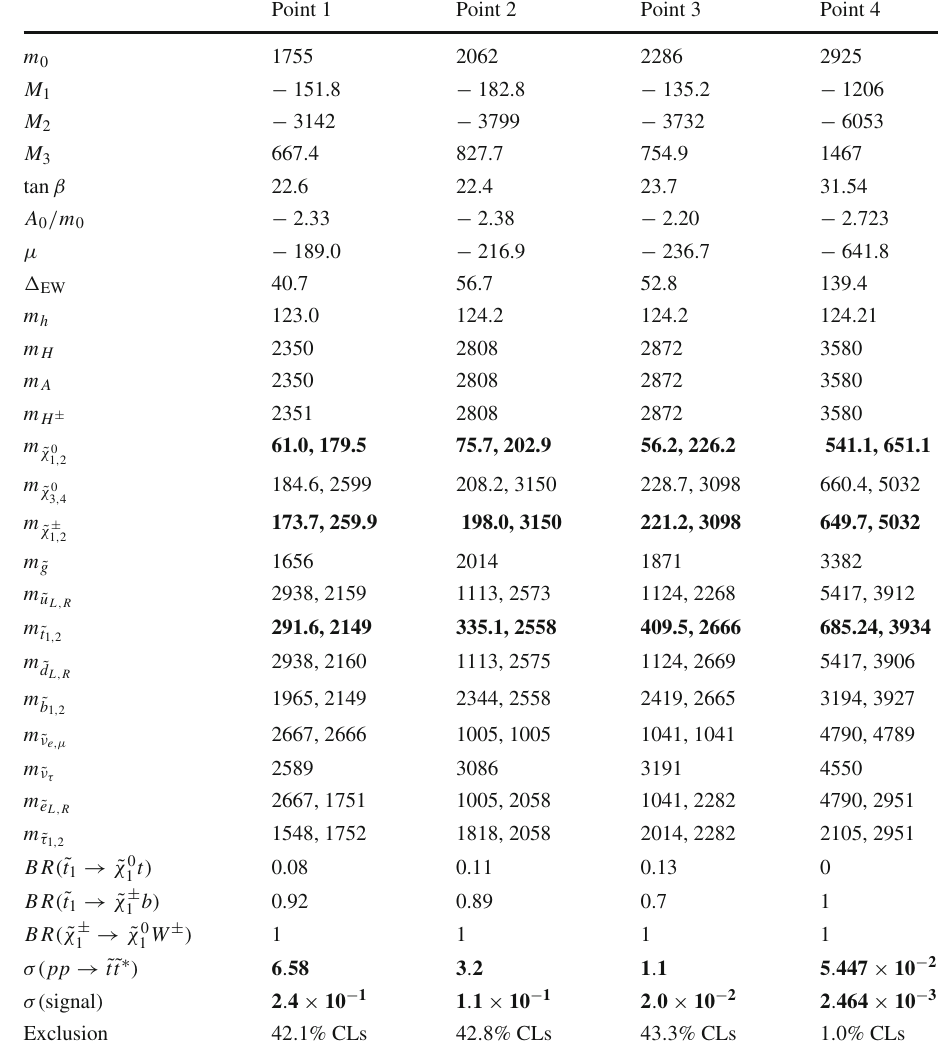
Table 2 Benchmark points for ˜ t → b ˜ χ ± with several mass 1 scales of the stop from about 291 to 685